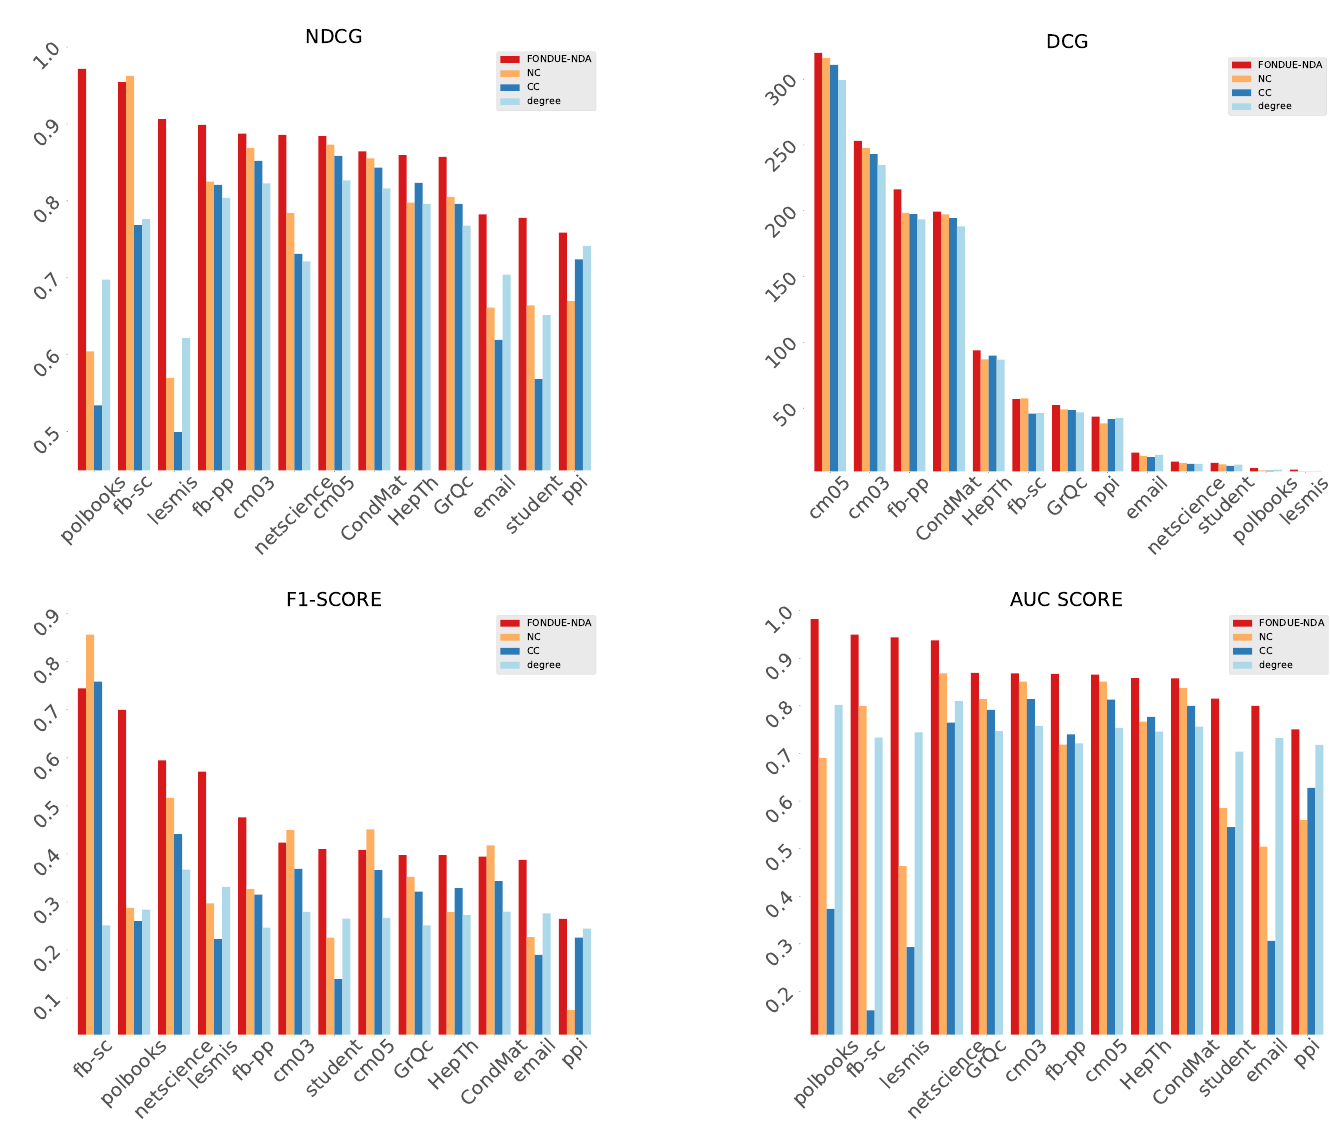
Figure 3. Bar plots for the diffent metrics (higher is better) for each dataset listed in Table 3, for each of the 4 measures, FONDUE-NDA, Degree, NC, CC, for network with 10% uniformly contracted nodes. More detailed results are listed in Appendix